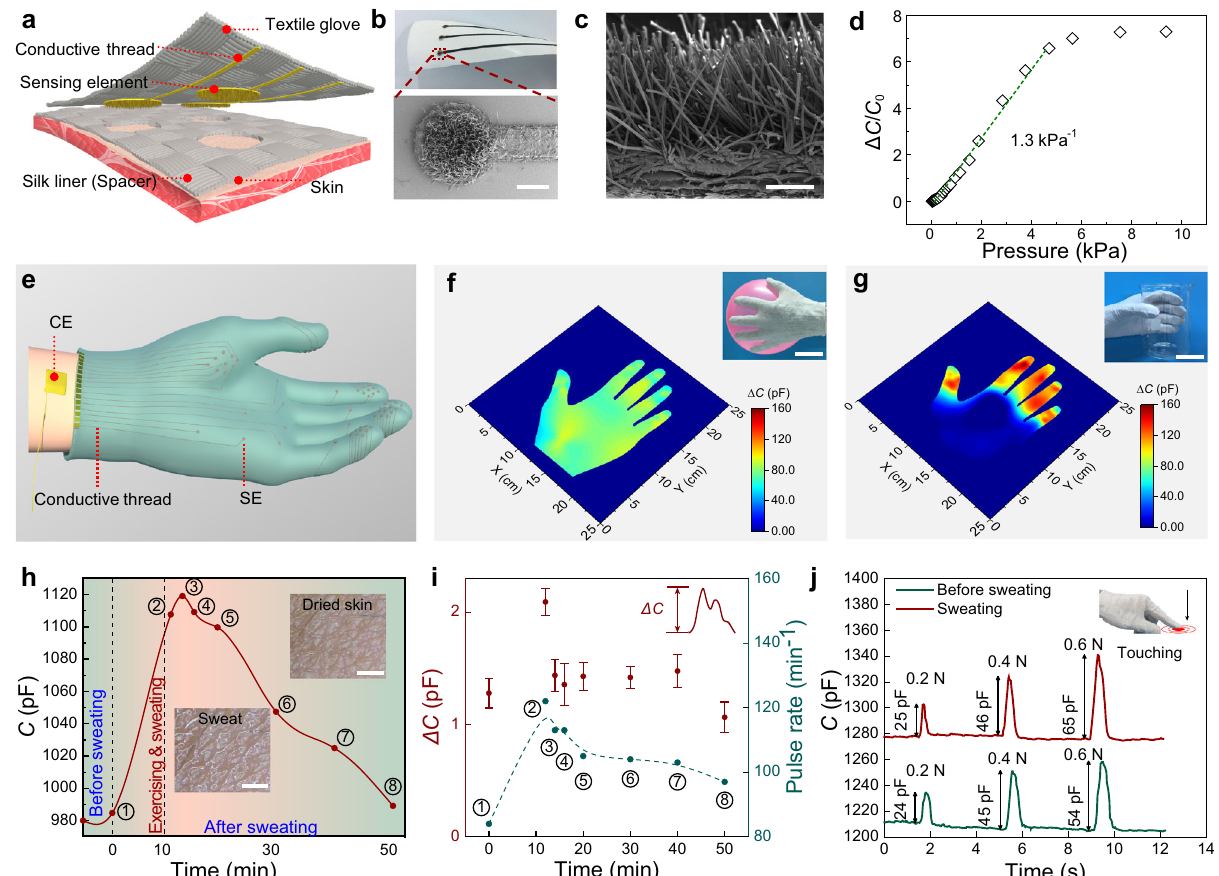
Fig. 5 All-textile smart glove for pressure mapping and pulse wave detecting. a Schematics of the fully textile sensing structure, showing a fully fabric structure that consists of a silk liner spacer, an electrode layer, and an outer protective glove. b Photograph of and low magni fi cation SEM image of the SE used in the smart glove. Scale bar: 1mm. c SEM image of the surface structures of the SE, showing tilted and slender pillars coated with a thin layer of Au fi lm. The SEM observation is repeated independently for three times and similar results are presented. Scale bar: 200 μ m. d Normalized change of capacitance as a function of applied pressure. e A three-dimensional schematic image of the smart glove. f , g Capacitance mapping of the smart glove worn on a healthy subject by holding f a balloon and g a beaker, indicating distinct pressure distributions for the two cases. Scale bar: 5cm. h Recorded capacitance during the test from a stationary state to exercise (lasting for 10min), and back to a rest state for 40min. Insets show the skin with sweat and after the sweat is dried. Scale bar: 2 mm. i The amplitudes and rates of pulse waves at 0, 12, 14, 16, 20, 30, 40, and 50min. n = 10 consecutive measurements, each one represents the value of amplitude of pulse wave. Data are presented as the mean values ± standard deviations: 1.27 ± 0.13, 2.09 ± 0.12, 1.43 ± 0.14, 1.35 ± 0.18, 1.42 ± 0.12, 1.41 ±